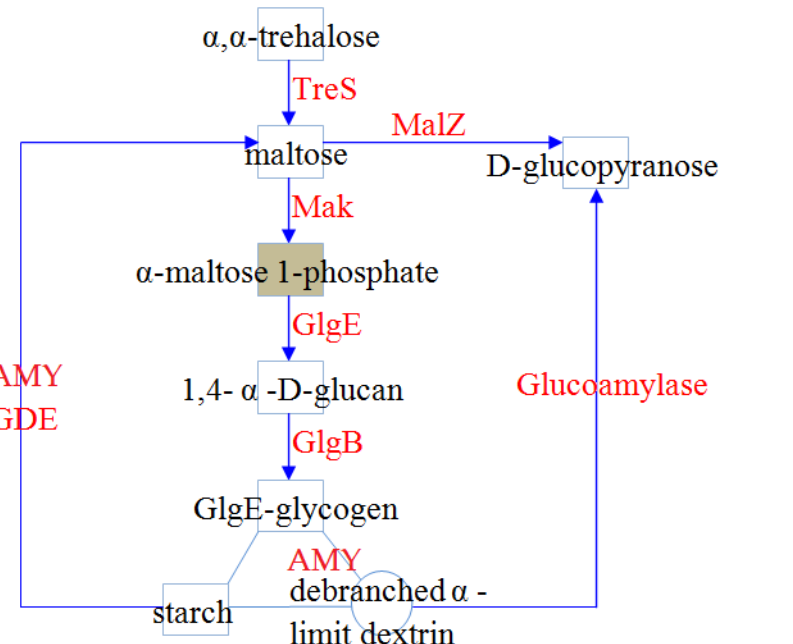
Figure 1. Predicted α -glucan metabolism pathways in S. thermotolerans Kr1 and S. thermosulfidooxidans 1269. Arrows indicate reactions catalyzed by the enzymes encoded by the genomes. TreS and Mak proteins compose a common trehalose synthase-fused maltokinase domain (TreS-Mak) of the multifunctional enzyme, which also contains an α -amylase catalytic domain (Amy). Abbreviations: TreS, trehalose synthase (EC 5.4.99.16); Mak, maltokinase (EC 2.7.1.175); GlgE (SS), starch/glycogen synthase ( α -1,4-glucan:maltose-1-phosphate maltosyltransferase) (EC 2.4.99.16); GlgB (BE), 1,4- α - glucan (glycogen) branching enzyme (EC 2.4.1.18); GDE, glycogen debranching enzyme (amylo- α -1,6- glucosidase) (EC 3.2.1.133); AMY, α -amylase (EC 3.2.1.1); MalZ, maltase-glucoamylase ( α -glucosidase) (EC 3.2.1.20); glucoamylase, glucan 1,4- α -glucosidase (EC 3.2.1.3) hydrolyzing glycogen, starch, or dextrins to glucose monomers. The metabolic map was constructed using MetaCyc [37] and Pathway collages [38]. Table 1. Enzymes of the GlgE-dependent polysaccharide biosynthesis and degradation pathways in S. thermotolerans Kr1 and S. thermosulfidooxidans 1269. Strain, ORF ID Protein Size (a. a.) Protein Similarity KO 1